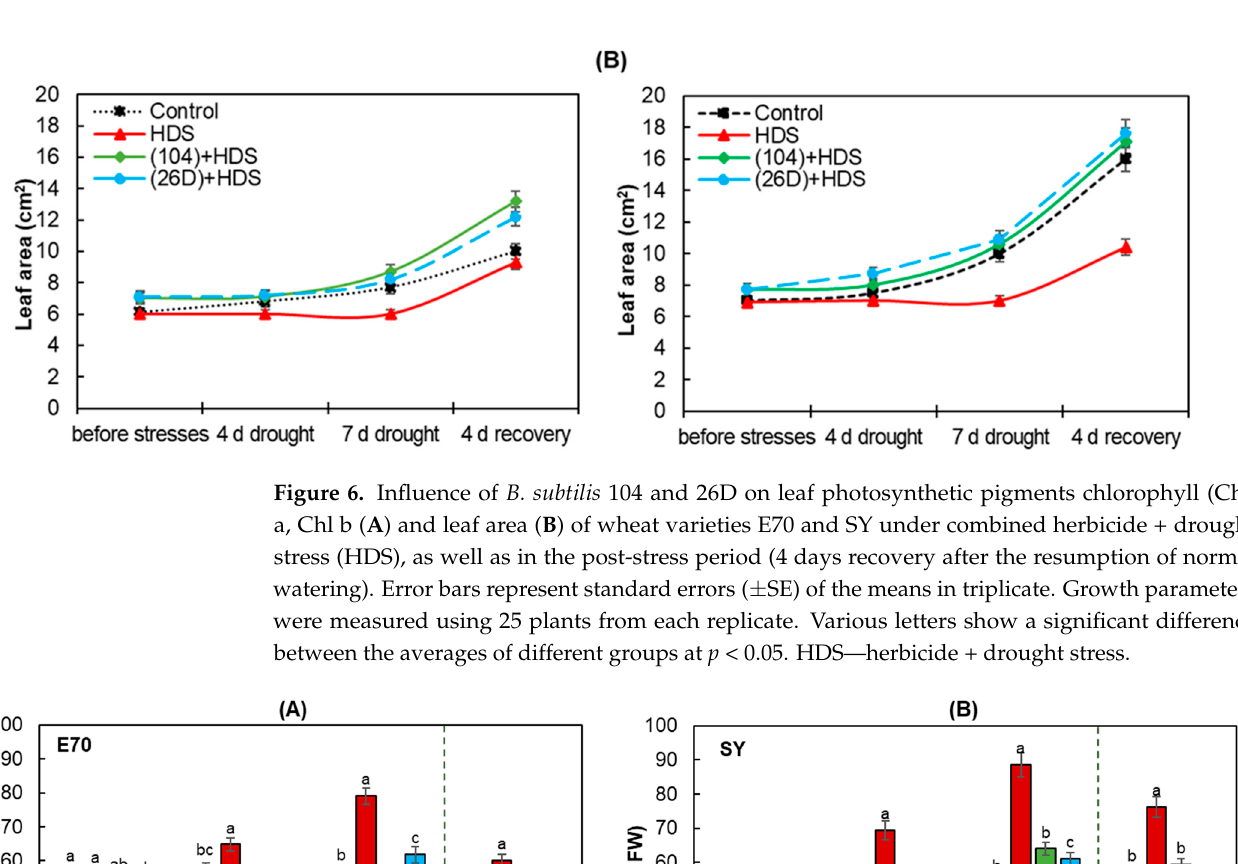
Figure 6. In fl uence of B. subtilis 104 and 26D on leaf photosynthetic pigments chlorophyll (Chl) a, Chl b ( A ) and leaf area ( B ) of wheat varieties E70 and SY under combined herbicide + drought stress (HDS), as well as in the post-stress period (4 days recovery after the resumption of normal watering). Error bars represent standard errors (±SE) of the means in triplicate. Growth parameters were measured using 25 plants from each replicate. Various le tt ers show a signi fi cant di ff erence between the averages of di ff erent groups at p < 0.05. HDS—herbicide + drought stress.